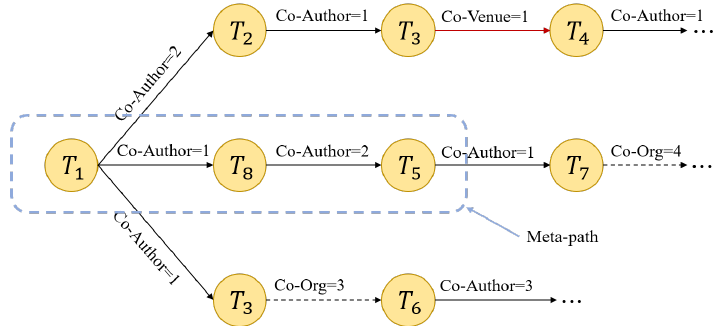
Figure 5. Local structure of heterogeneous graph